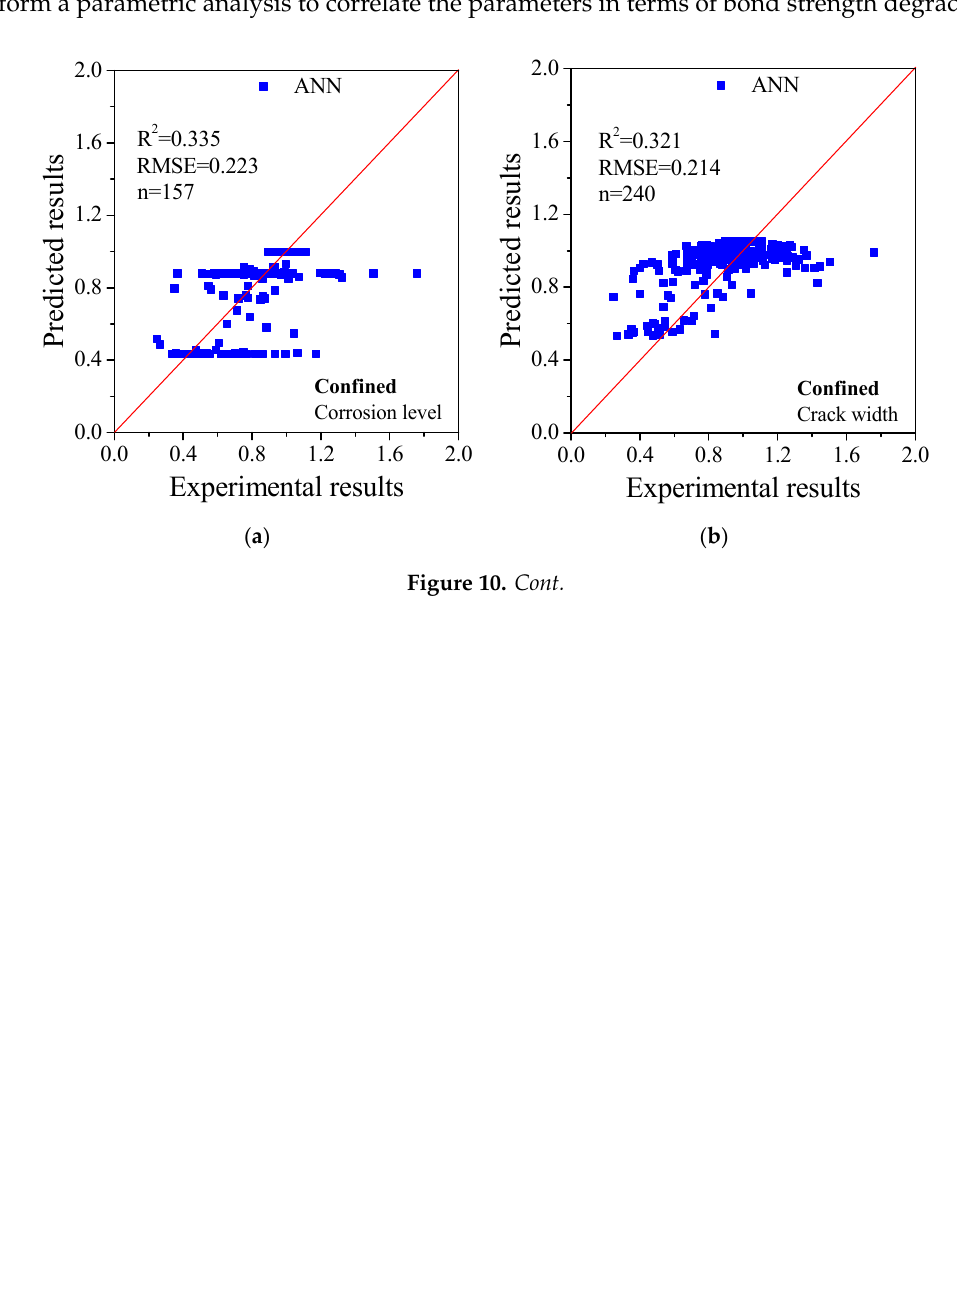
Figure 9. Comparison of the results calculated by ANN method considering different parameters for the unconfined cases: ( a ) corrosion level; ( b ) crack width; ( c ) corrosion level and cover to diameter ratio; ( d ) corrosion level and crack width; ( e ) corrosion level, crack width, cover to diameter ratio and concrete